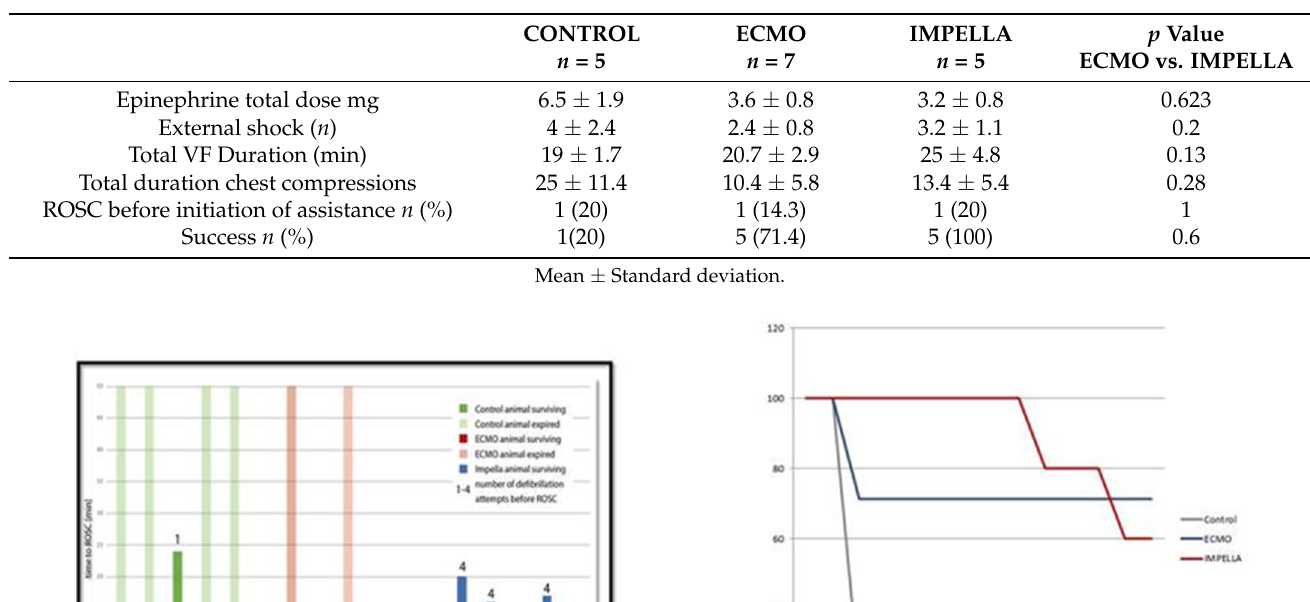
Table 1. Comparison of resuscitation parameters.